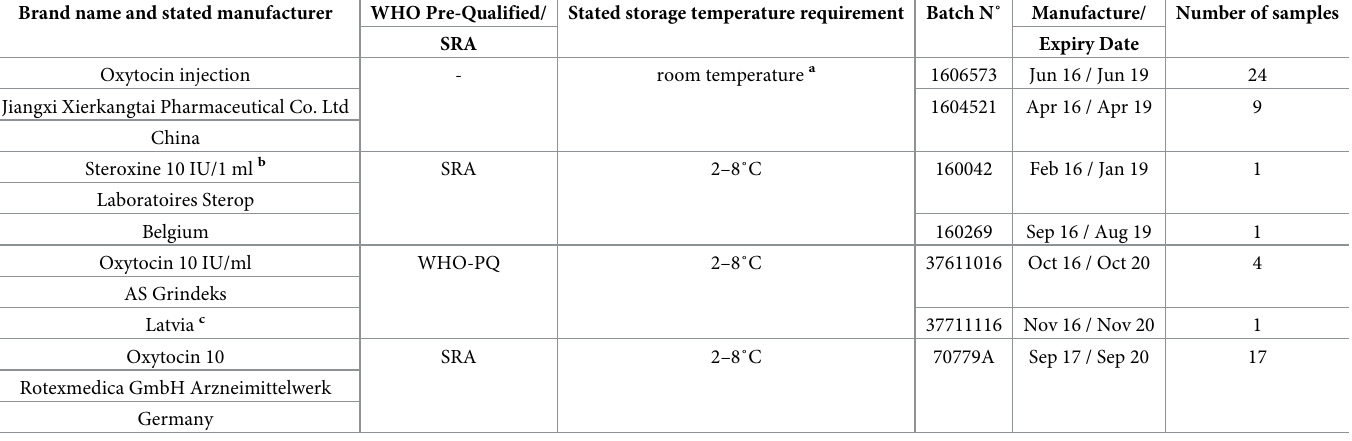
Table 1, three further private pharmaceutical wholesalers in Kigali were contacted, as well as the procurement organization for faith-based health facilities, i.e. the Bureau de Formations Table 2. List of oxytocin brands and batches collected in this